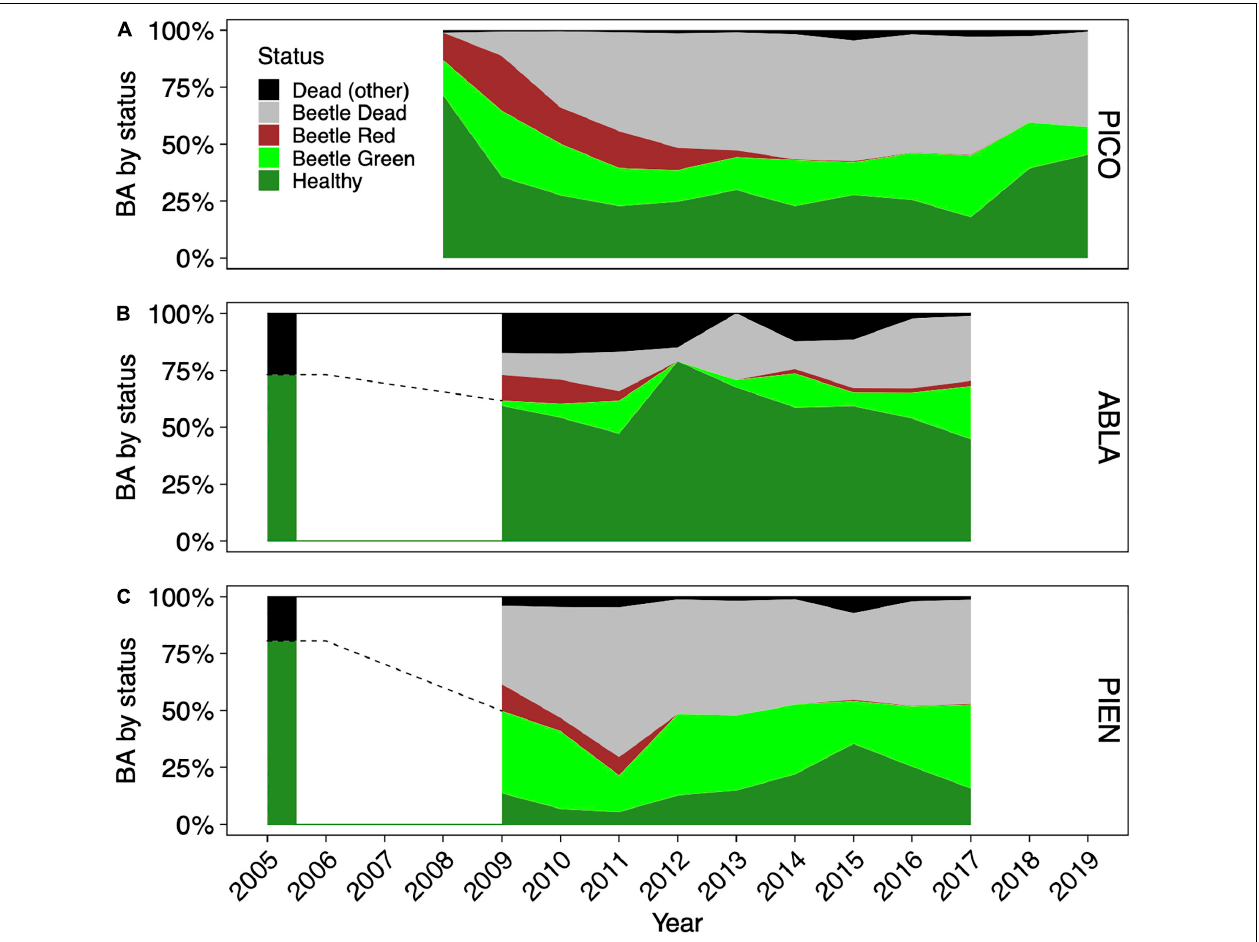
FIGURE 2 | Bark beetle impacts on basal area (BA) for the three main forest tree species lodgepole pine [PICO; (A) ], subalpine fir [ABLA; (B) ], and Engelmann spruce [PIEN; (C) ]. Continuous data range from 2008 to 2019 for lodgepole pine (A) , from 2009 to 2017 for subalpine fir (B) and Engelmann spruce (C) . The 2005 data for subalpine fire and Engelmann spruce did not include information on beetle attack or mortality but were included to show pre-epidemic proportion of living trees (B,C) . The dashed lines from 2005 to 2009 for ABLA and PIEN indicate the approximate trajectory of tree mortality as no data were collected in these